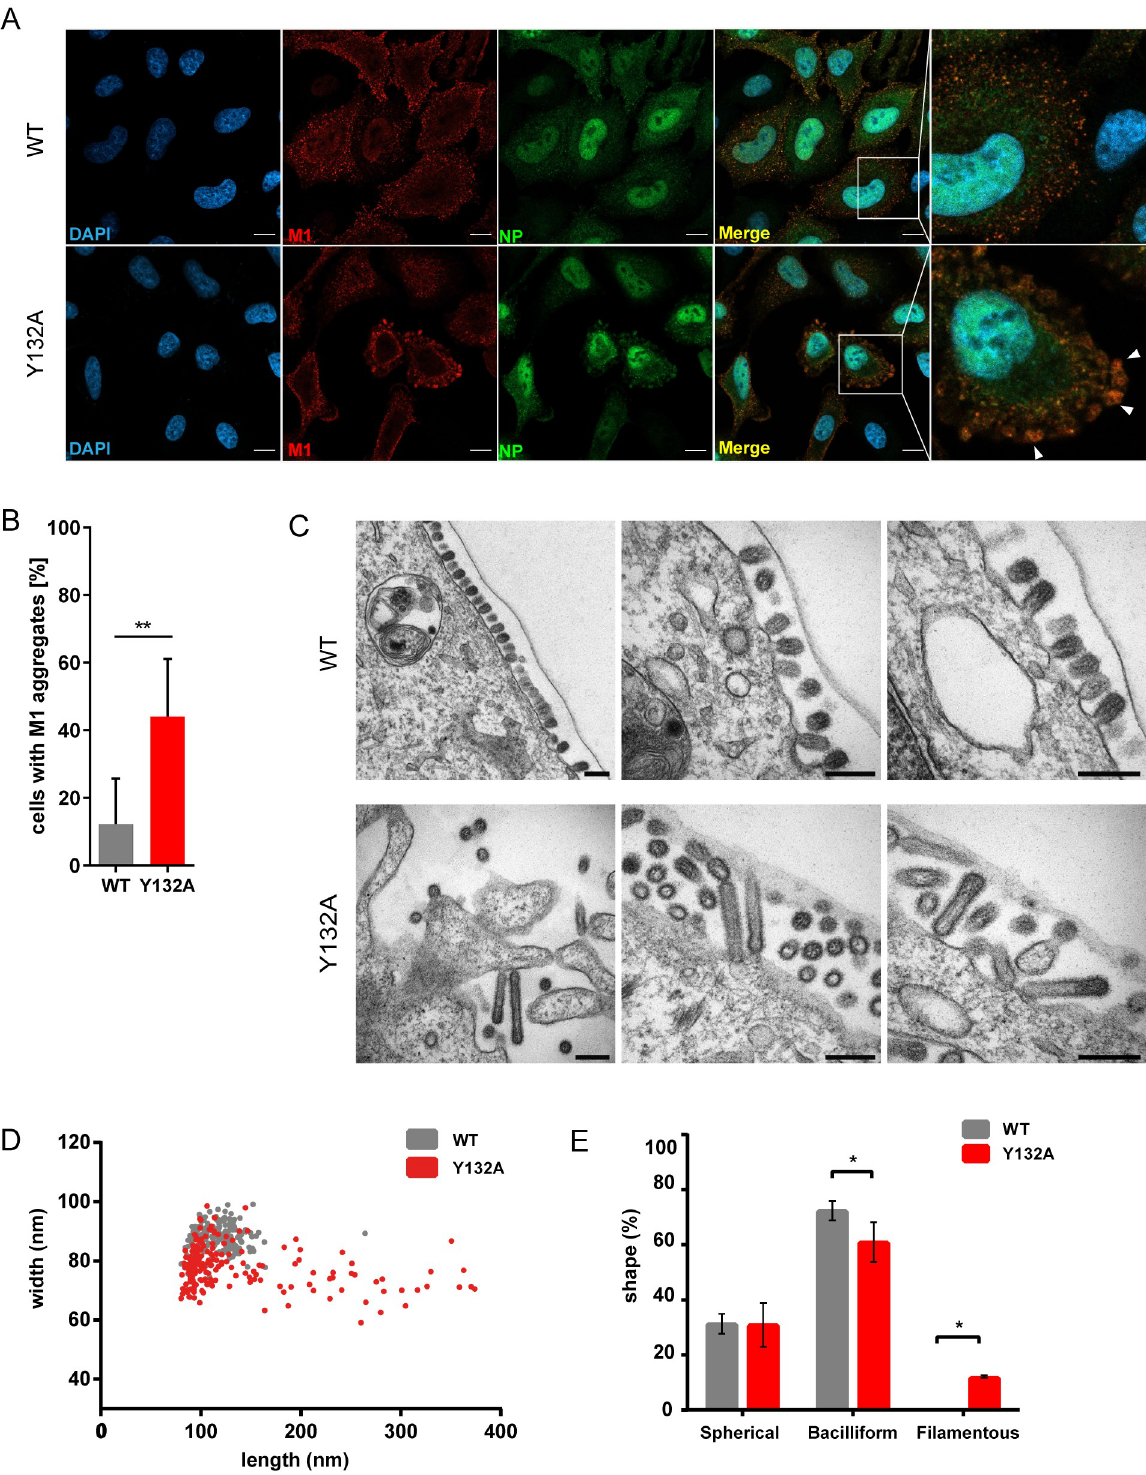
Fig 3. Presence of M1 Y132A induces the formation of filamentous particles. A-E) A549 cells were infected with WSN WT or M1 Y132A (MOI 5) for 9 h. A) Cells were fixed and analyzed for M1 localization (red) by indirect immunofluorescence. NP (green) was used as marker for vRNP localization and nuclei were stained with DAPI (blue). Pictures were taken with LSM800 confocal microscope and analyzed with Fiji/ ImageJ version 1.51n. Scale bar: 10 μ m. Arrows point to M1 aggregates at the cell periphery. Pictures are representatives of two independent